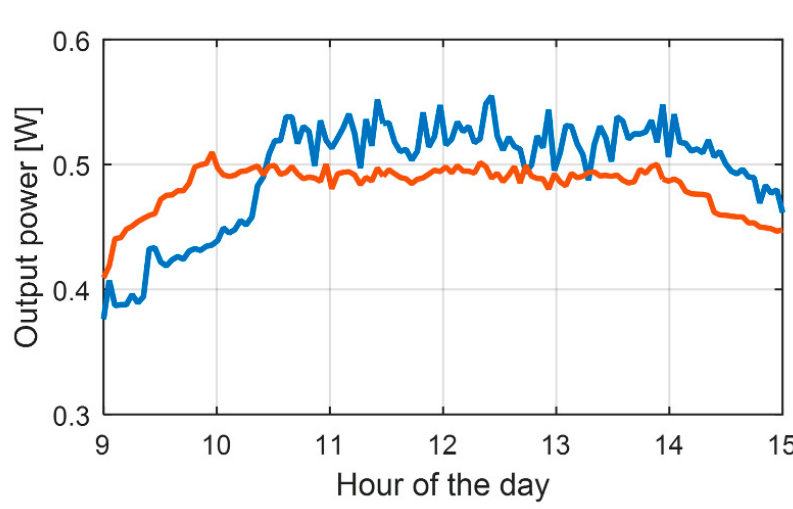
Figure 25. Output power for days with high radiation.